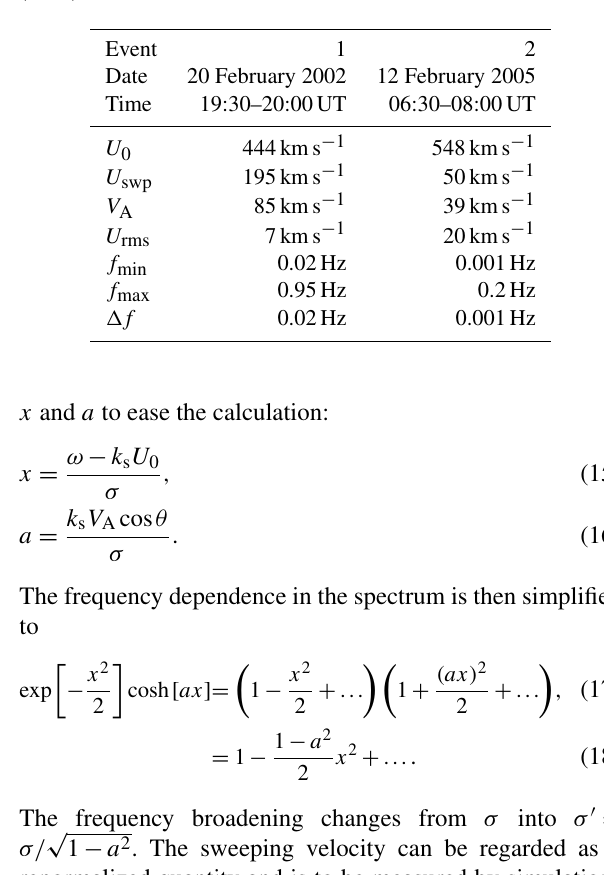
Table 1. Parameters for the error estimate of Taylor’s hypothesis for two events of Cluster spacecraft measurements of solar wind turbulence: event 1 from Narita et al. (2013) and event 2 from Narita